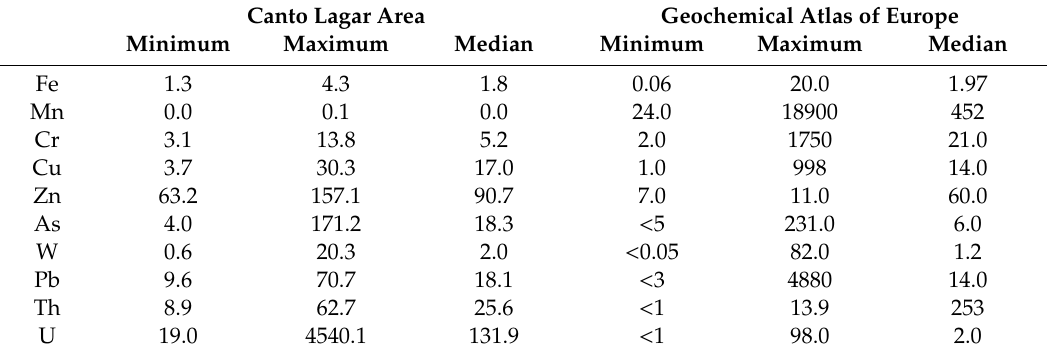
Table 4. Comparison of Fe (%) and selected potential toxic element (mg/kg) contents from Canto Lagar sediments and Geochemical Atlas of Europe.